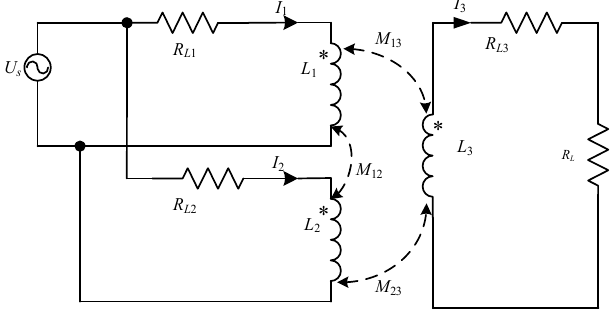
Figure 5. The equivalent circuit of the proposed structure.